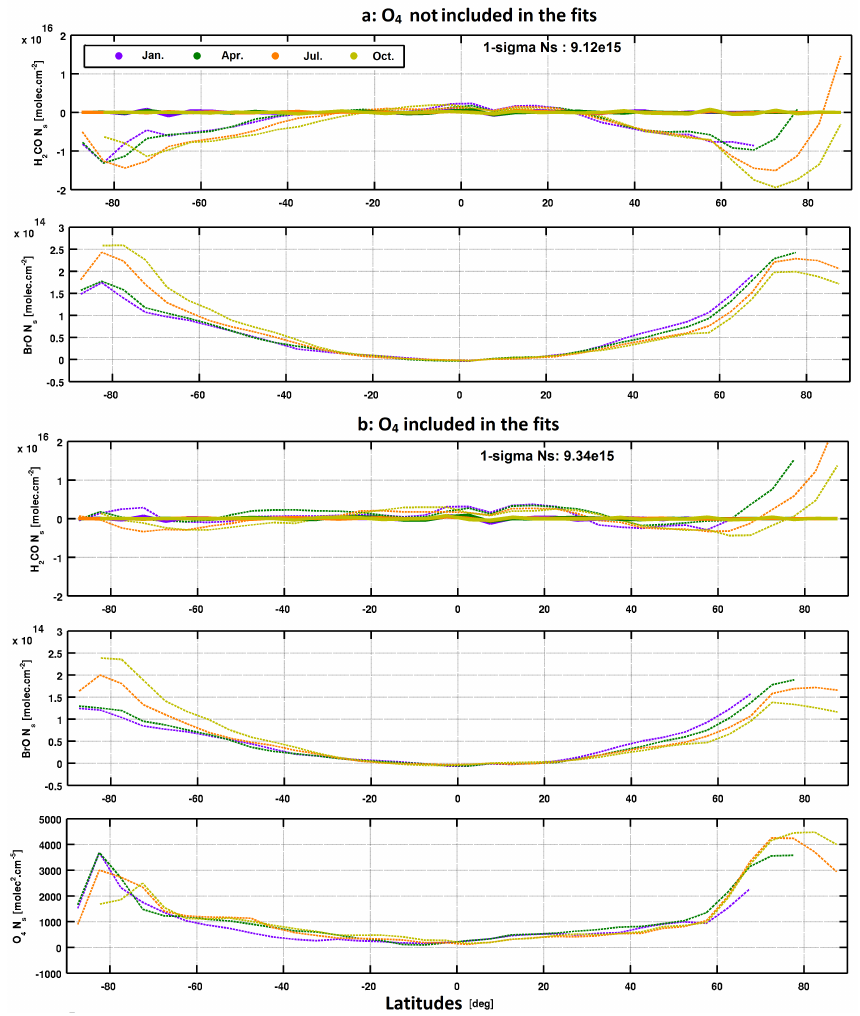
Figure 4. Averaged zonal variation of the H 2 CO, BrO and O 4 differential slant columns for 4 months of OMI observations in 2005 (January, April, July, October), over the Pacific Ocean, as a function of the latitude (a) when O 4 is not included in the fit (v12), and (b) when O 4 is included and pre-fitted in w1 (v14). Dashed lines show the slant columns before the background normalisation procedure, while the plain lines show the normalised H 2 CO slant